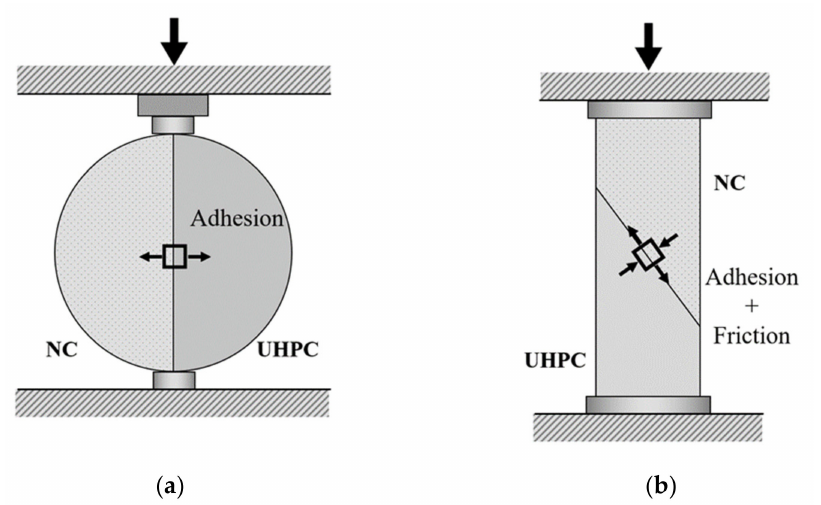
Figure 1. Testing methods for UHPC–NC bond strength. ( a ) Splitting test; ( b ) slant shear